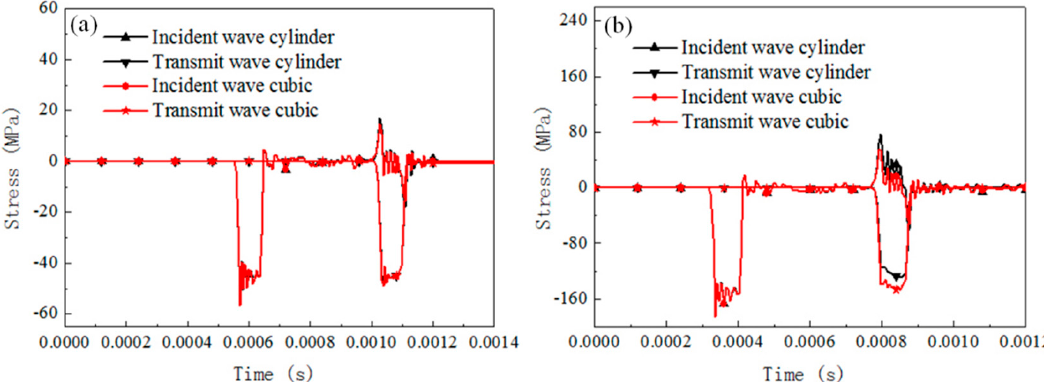
Figure 9. Comparison of the reflected and transmitted waves for cylinder specimen and cubic specimen with rate-dependent elastic-plastic material (u = 0). ( a ) Impact velocity of 3 m/s, ( b ) impact velocity of 10 m/s.